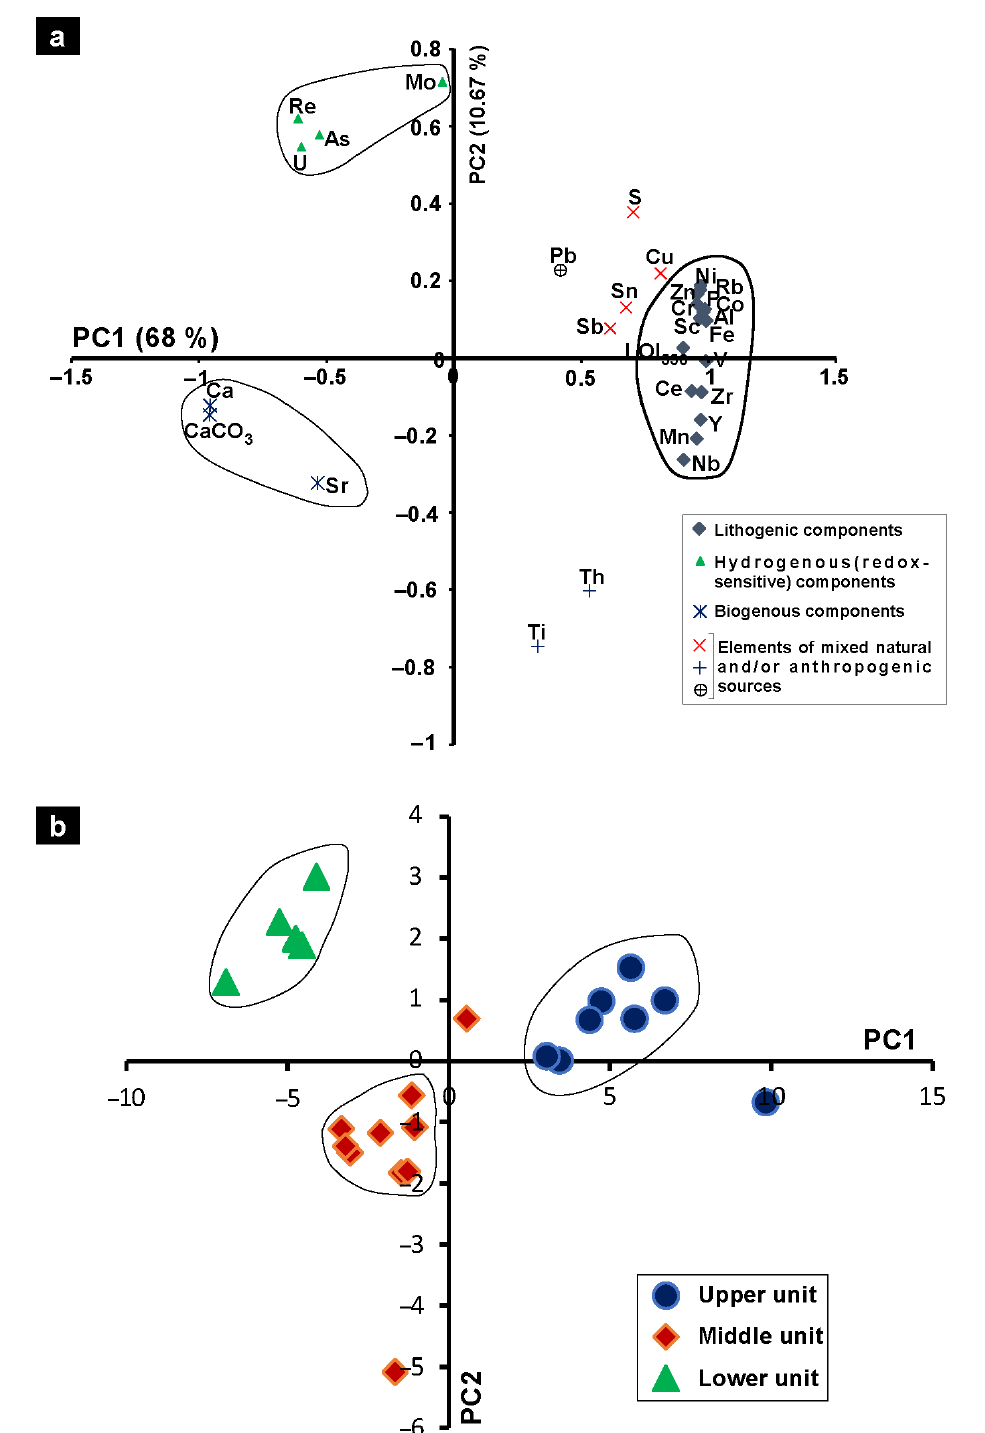
Figure 7. ( a ) Biplot of PC1 and PC2 (R-mode) loading and clustering of elements (variables) into lithogenous having higher PC1 and PC2 loading, redox-sensitive elements having negative PC1 and positive PC2 values, and carbonate related elements having negative PC1 and PC2 loadings. ( b ) Biplot of PC1 and PC2 (Q-mode) loading and subdivision of the core into three units. Samples (cases) in the upper unit having high component 1 scores are enriched in lithogenous elements, and other sediments (middle and lower units) are enriched in biogenous and hydrogenous